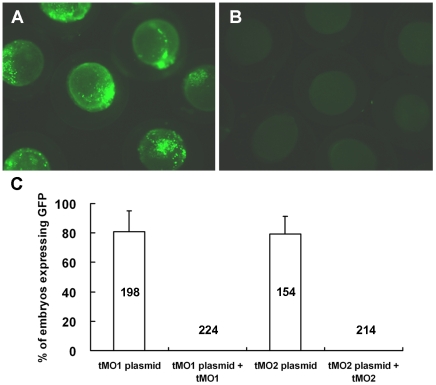

Cfl1 MOs efficiently block the translation of GFP fusion constructs containing respective MO binding site.Embryos at 1-cell stage were injected with 330 pg pCS2+ XLT fused with a fragment of cfl1 gene sequence from −22 to +195 or −52 to +51 in the absence or presence of 7.5 ng cfl1 tMO1 or tMO2, respectively. The expression of GFP was examined at 10 hpf and photographed under epifluorescent microscopy. The representative photos for embryos treated without cfl1 MO (A) and with tMO1 (B) are shown and the percentages of injected embryos expressing GFP are shown in average ± standard deviation (C).